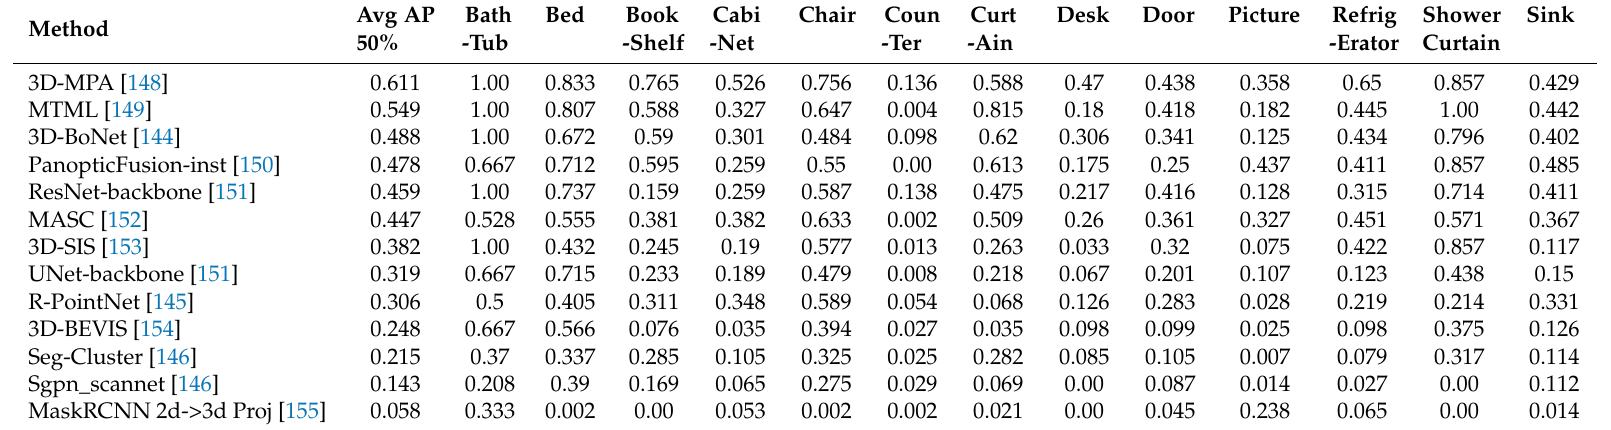
Table 6. Instance segmentation on the ScanNet dataset. The measure is mean average precision (AP) at an overlap of 0.5